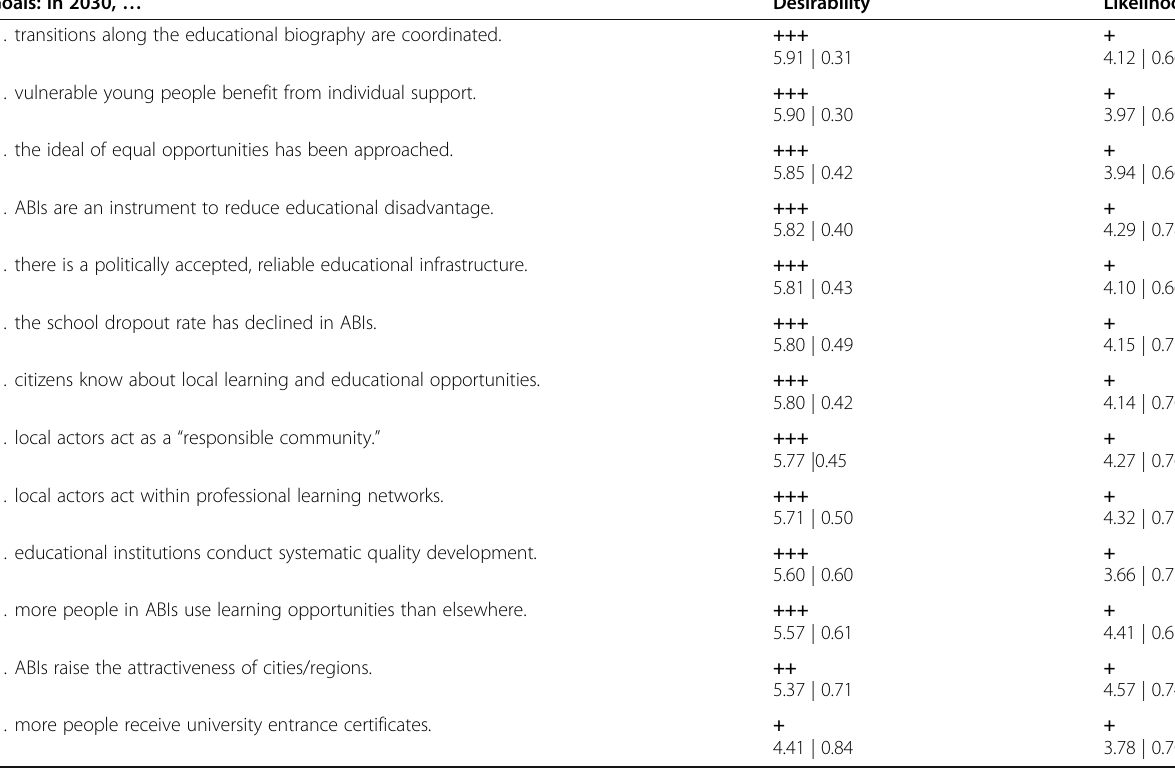
Table 3 Means and standard deviations for statements on ABI goals Goals: In 2030, … Desirability